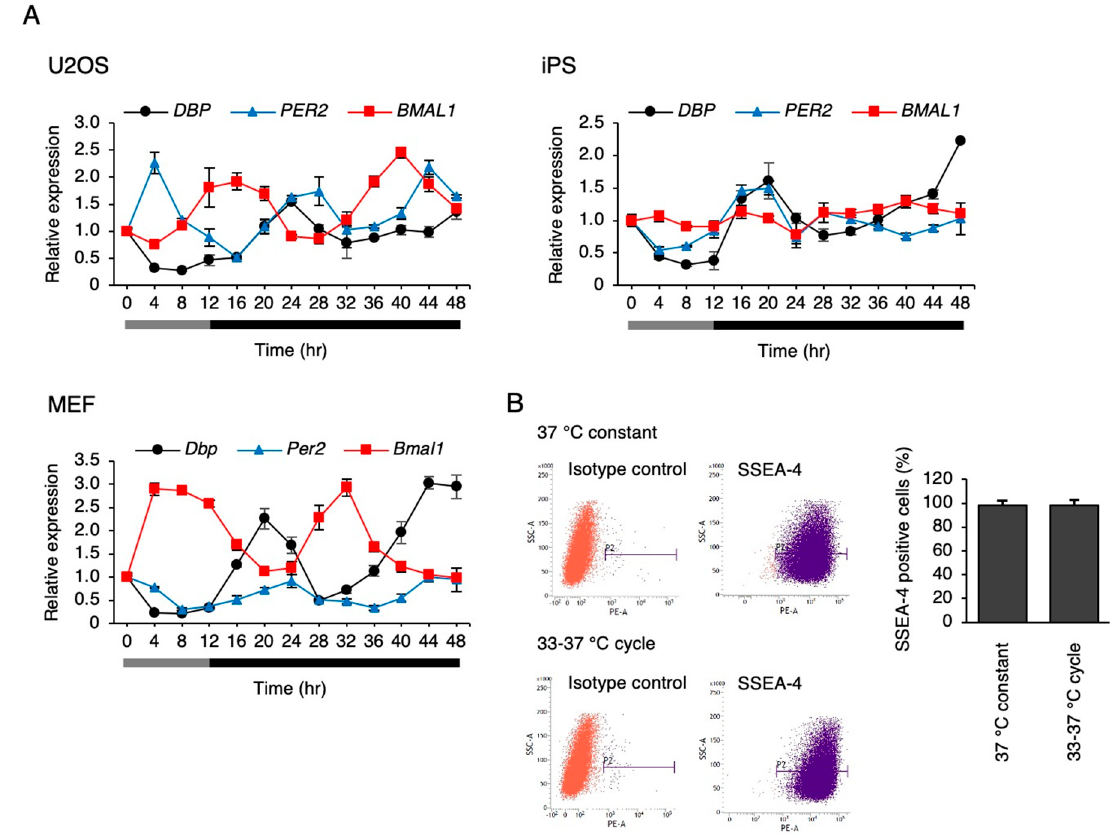
Figure 6. The response of clock genes to the simulated rhythm of body temperature. ( A ) The expression levels of clock genes under the temperature rhythm in U2OS cells, hiPSCs, and mouse embryonic fibroblasts (MEFs). 0 h refers to the start of day 5 of the temperature rhythm. The temperature was set at 33 ◦ C from 0 to 12 h (gray bar) and then at 37 ◦ C from 12 to 48 h (black bar). Data are presented as the means ± SEM relative to 0 h. n = 3 for each comparison. P values for the rhythmicity of DBP , PER2 , and BMAL1 were determined by a cosinor analysis with p = 0.04, p = 0.12, and p < 0.01 in U2OS cells; p = 0.02, p = 0.35, and p = 0.43 in hiPSCs; and p < 0.01, p < 0.01, and p < 0.01 in MEF. ( B ) The pluripotency marker SSEA-4-positive cells in hiPSCs after a 6 day culture according to temperature rhythm. P2 indicates the SSEA-4 positive region, and the bar graph shows the percentage of SSEA-4-positive cells. Data are presented as the means ± SEM; n = 4 for each comparison.